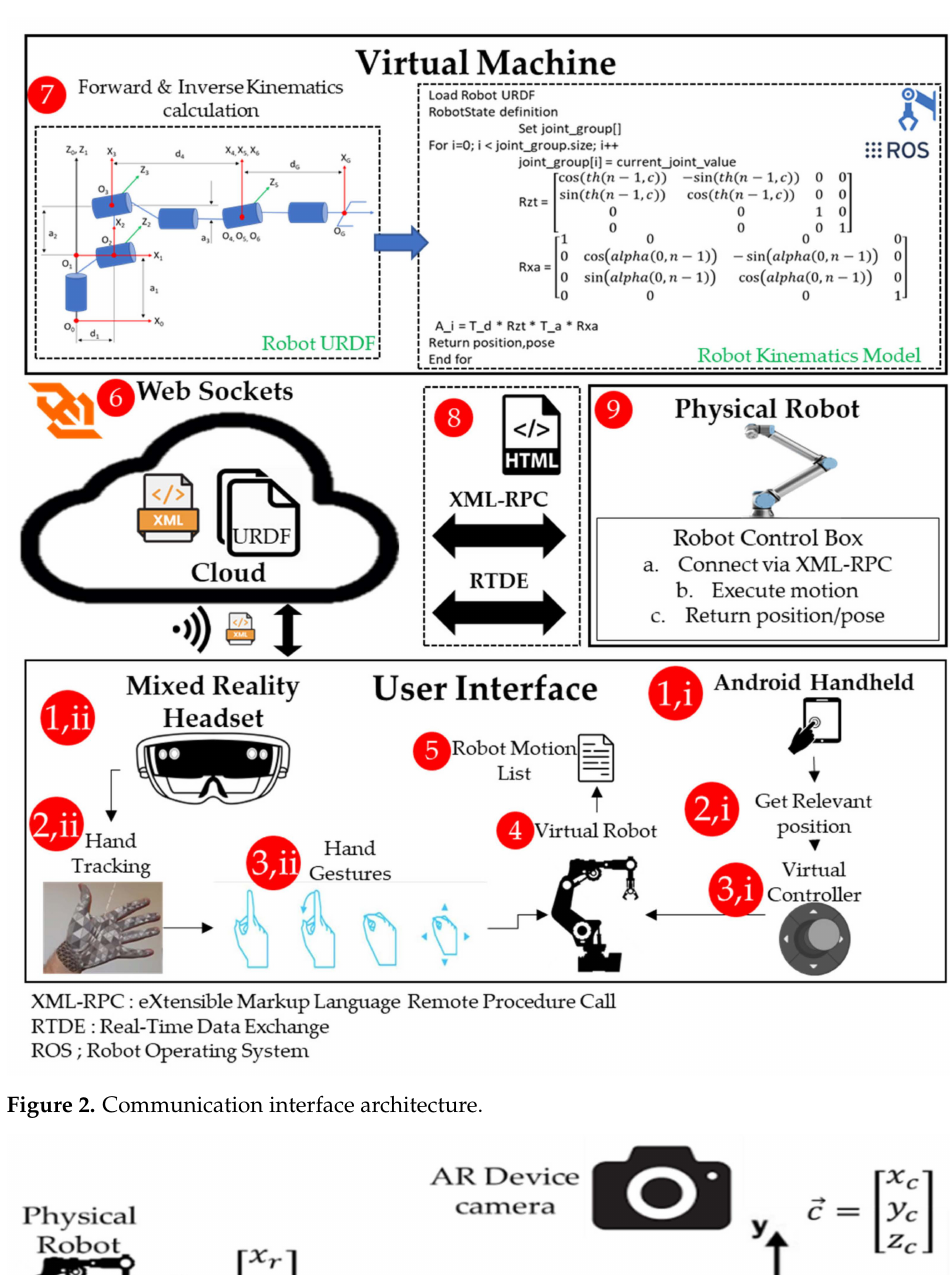
Figure 2. Communication interface architecture.